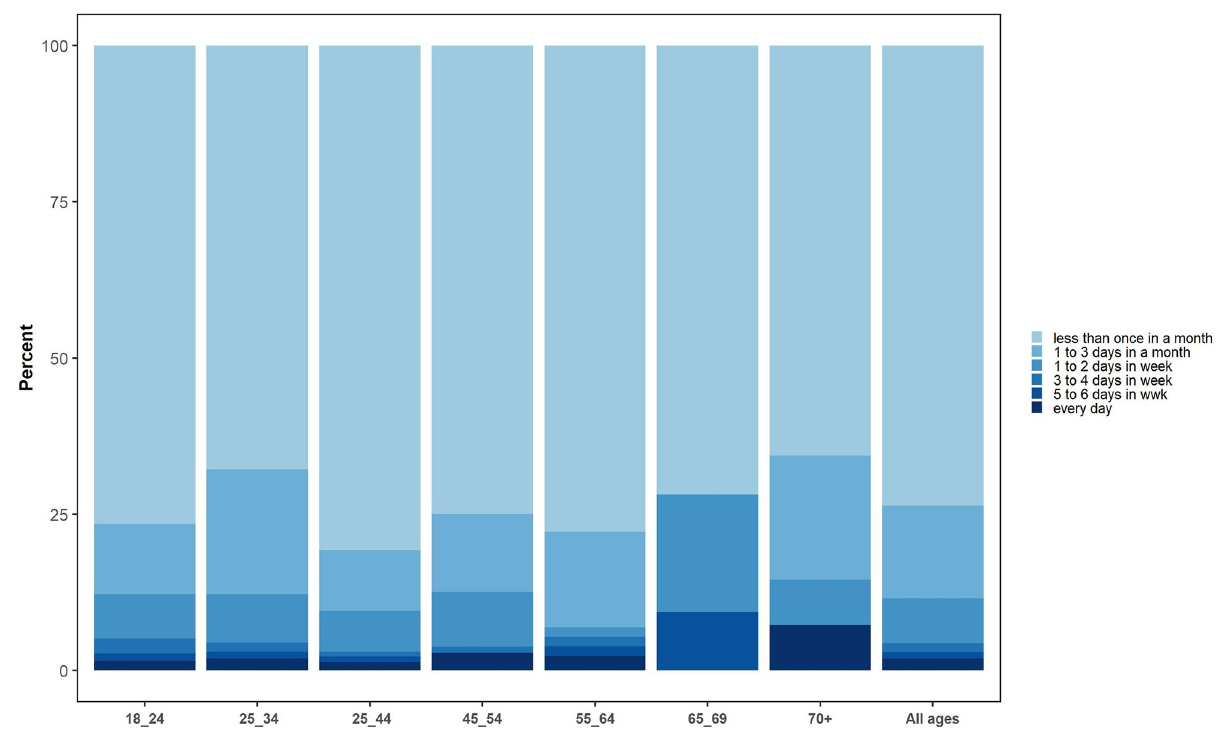
Fig 2. Drinking frequency in last 12 months (at national level by age